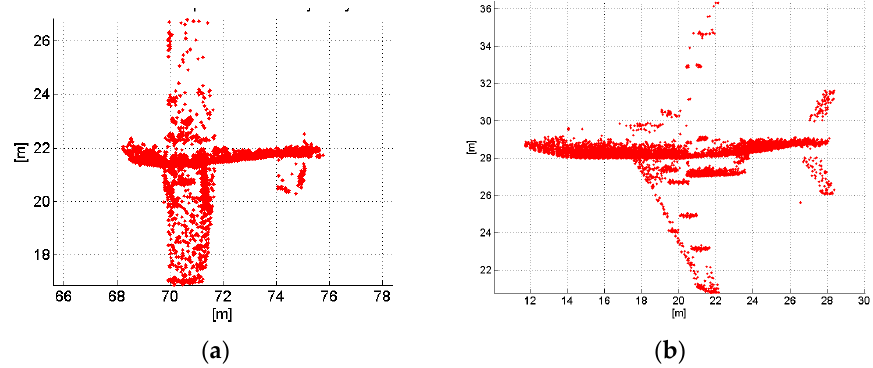
Figure 18. Reconstruction of different aircraft types, ( a ) Cessna and ( b ) Learjet.